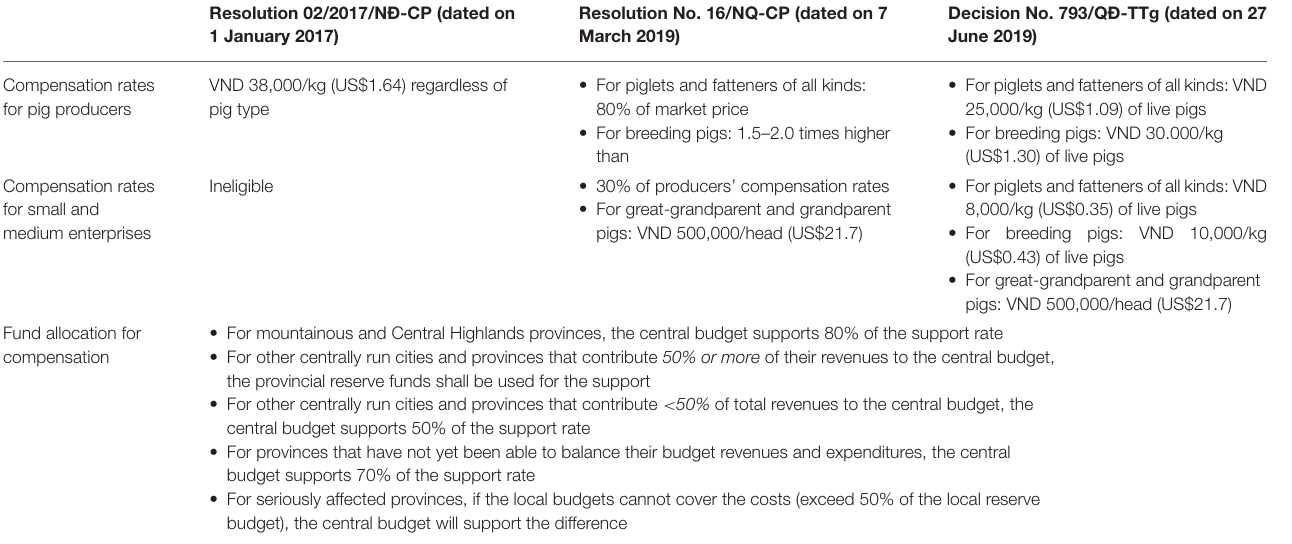
TABLE 7 | Compensation schemes for ASF infected